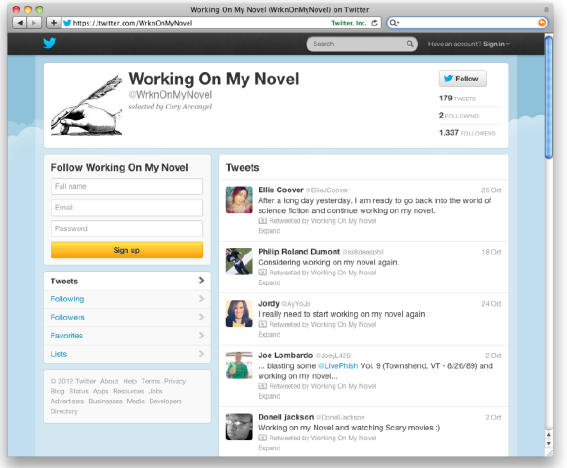
Figure 6 | Cory Arcangel, Working On My Novel (2012-2015) Twitter feed.